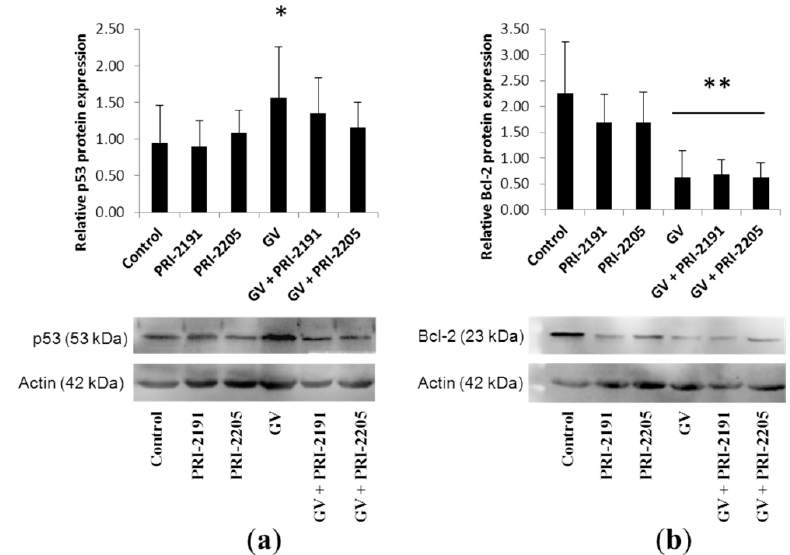
Figure 7. ( a ) p53 and ( b ) Bcl-2 expression in A549 lung cancer tumor tissue determined by Western blot: immunoblot and densitometric analysis (mean ± SD). GV, imatinib; PRI-2191 and PRI-2205, vitamin D analogs; * p < 0.05 compared to control and PRI-2191, ** p < 0.05 compared to control, PRI-2191 and PRI-2205, ANOVA followed by Fisher’s test.